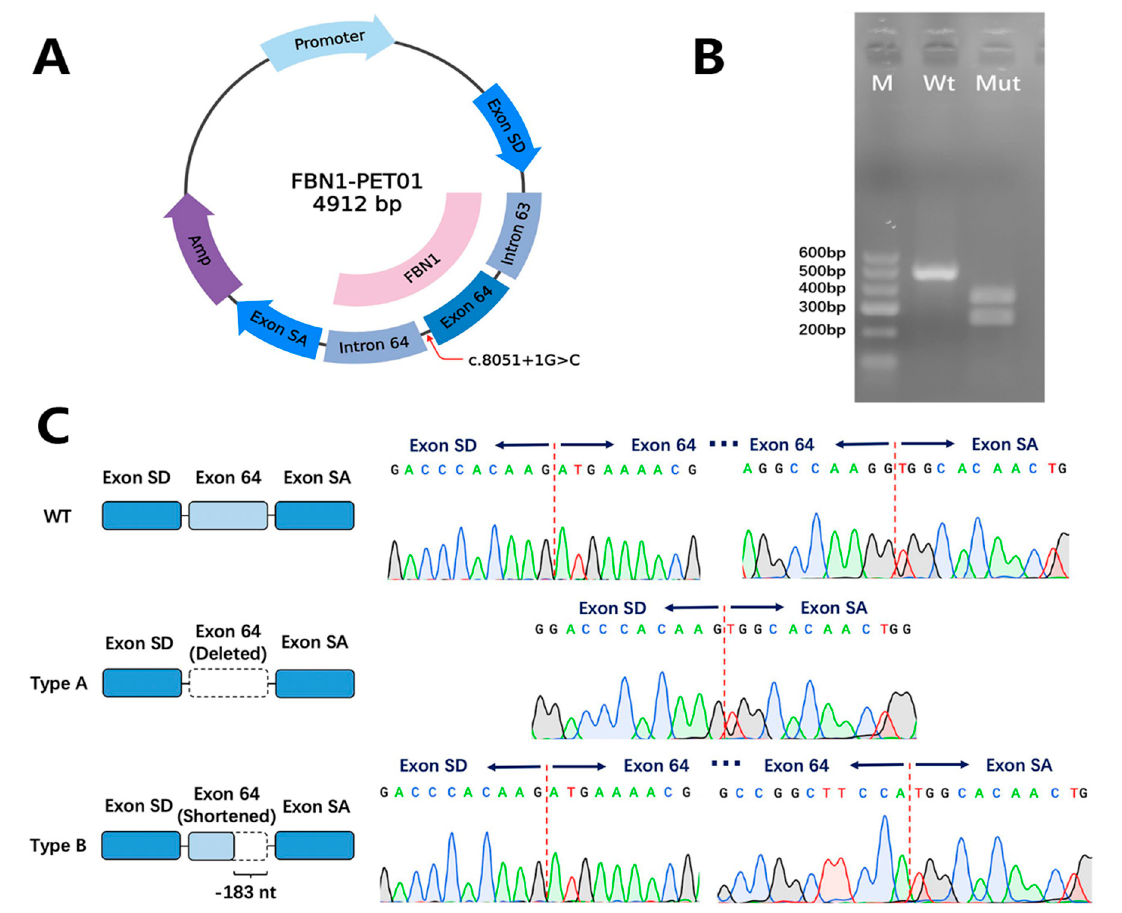
Figure 3. The results of the minigene assays of the splice-altering mutation. ( A ) The construction of the FBN1-PET01 minigene plasmid. ( B ) The electrophoresis result of the wild-type and mutant cDNA products. M represents marker. Wt represents cDNA from the wild-type plasmid. Mut represents cDNA from the mutant plasmid. ( C ) A schematic diagram and the Sanger sequencing results of the wild ‐ type and two mutant cDNA products.